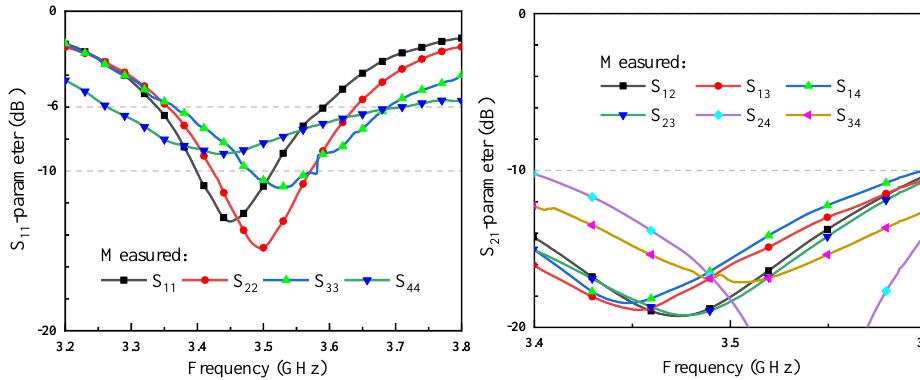
Figure 11. Measured reflection coefficient and transmission coefficient.